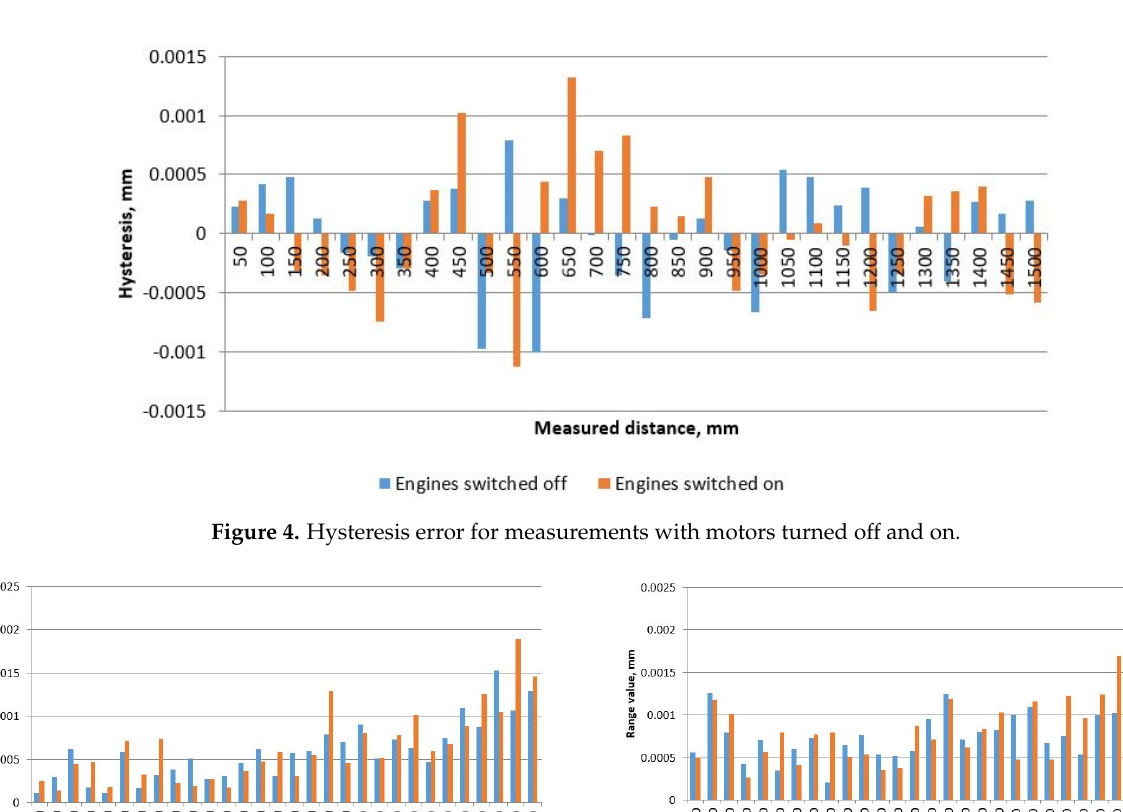
Figure 3. Averaged error values during measurement: ( a ) increasing direction, inactive motors; ( b ) decreasing direction, inactive motors; ( c ) increasing direction, active motors; ( d ) decreasing direction, active motors. Error bars show the standard deviation value.